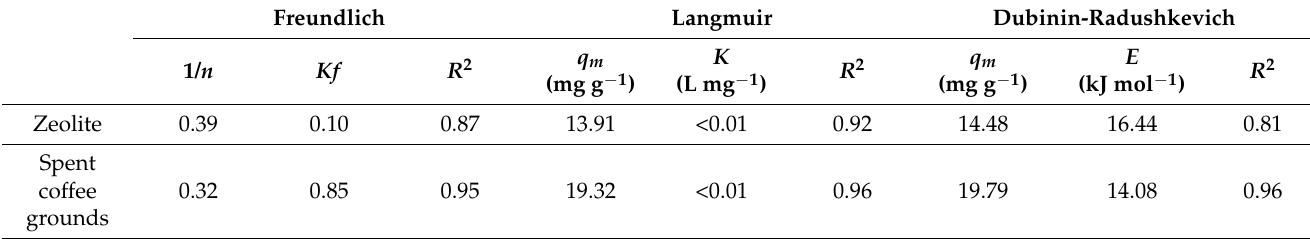
Table 6. Adsorption parameters of zeolite and spent coffee grounds for Cd. Own compilation based on literature data